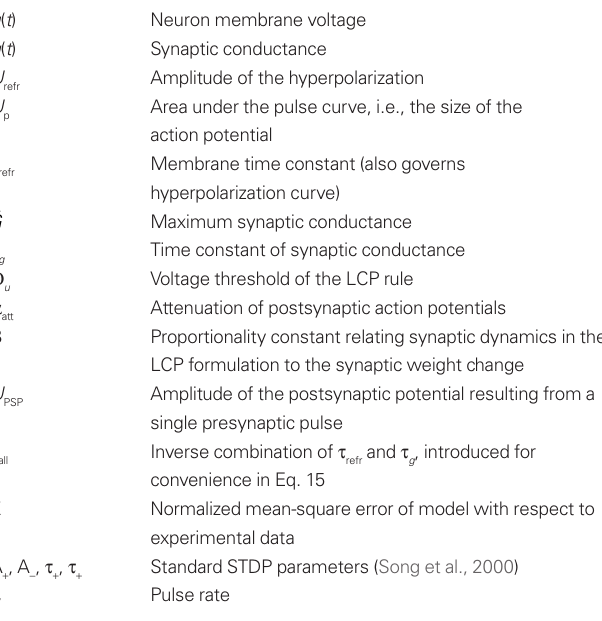
Table 2 | Listing of symbols used in the analysis of LCP with SrM in Section “LCP with SrM Neuron” and LCP with LiAF in Section “LCP with LiAF